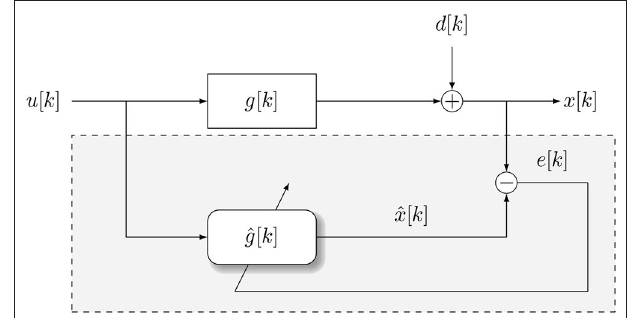
FIGURE 2 | Sketch of the adaptive filtering concept for the system identification